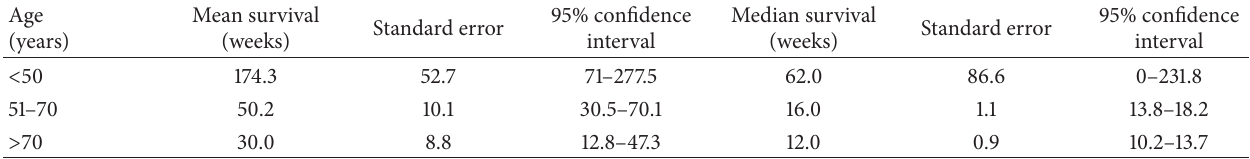
Table 4: Mean and median survival in patients with anaplastic thyroid cancer (in weeks) in relation to